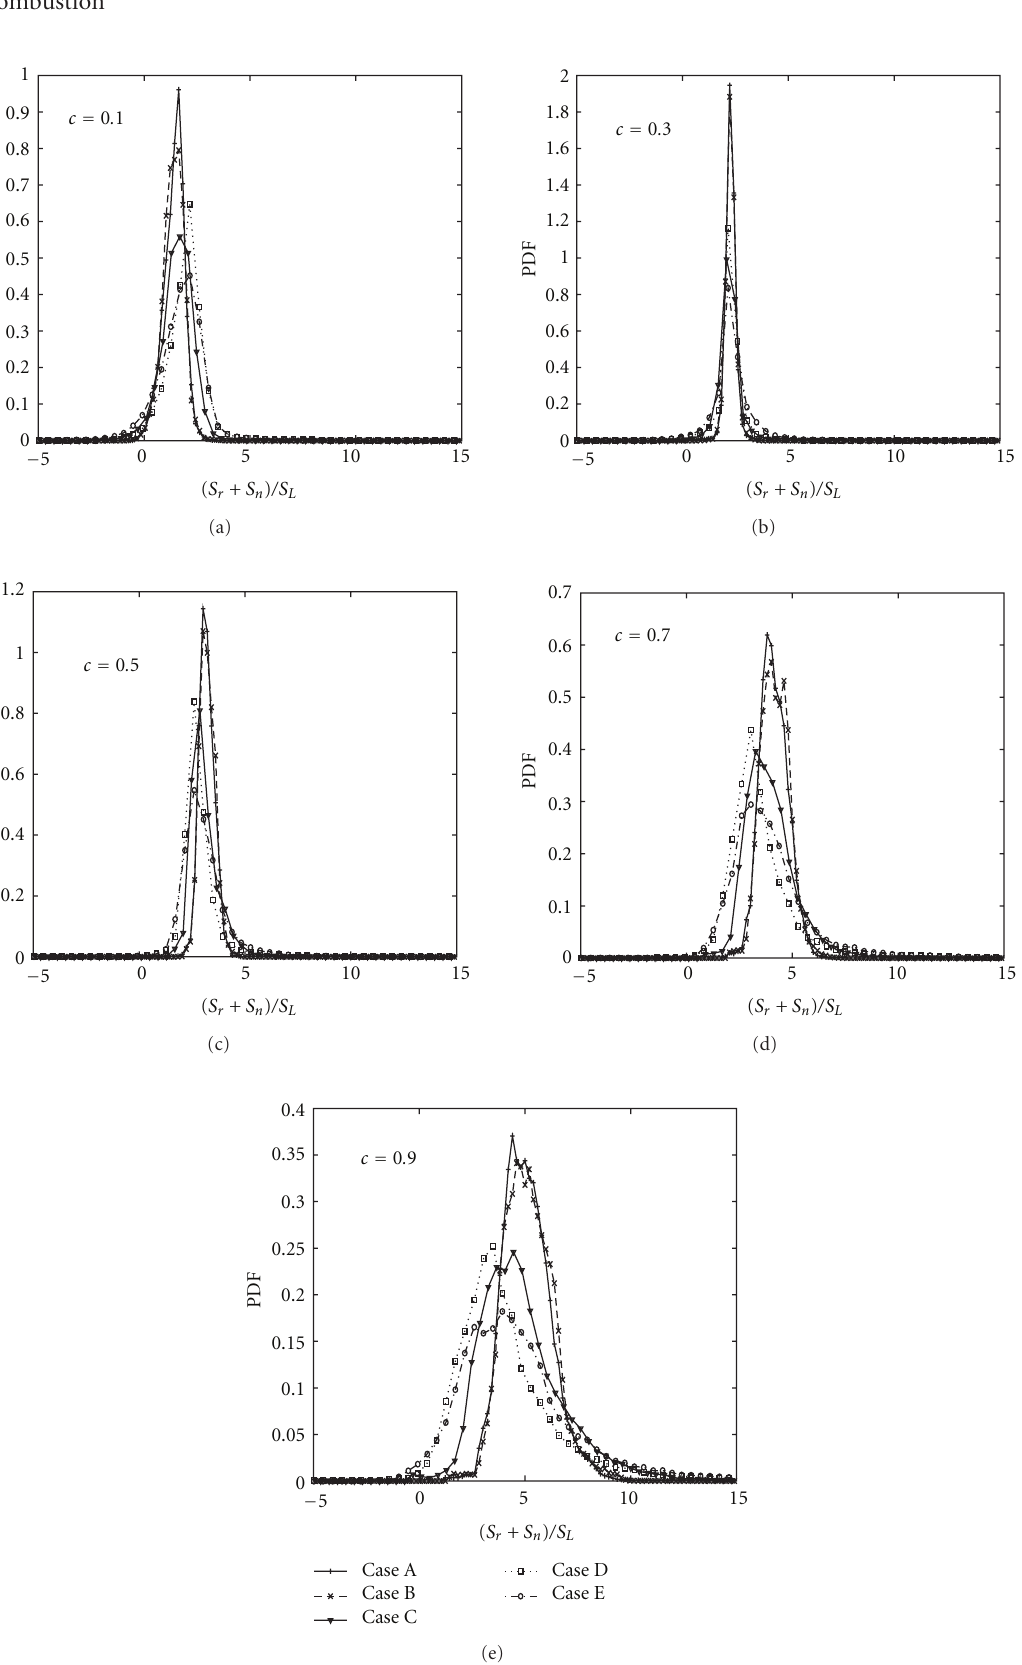
Figure 3: Pdfs of normalised combined reaction and normal di ff usion component of displacement speed ( S r + S n ) /S L on the c = (a) 0.1, (b) 0.3, (c) 0.5, (d) 0.7, and (e) 0.9